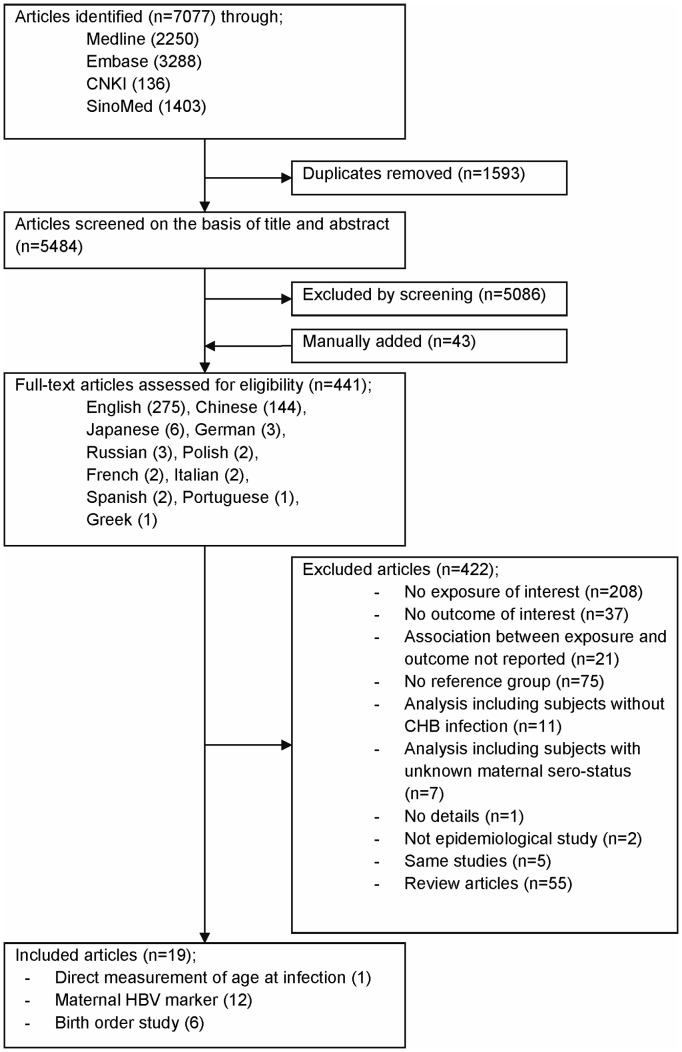
Flow diagram of study selection.Abbreviations: CHB, chronic hepatitis B; HBV, hepatitis B virus.